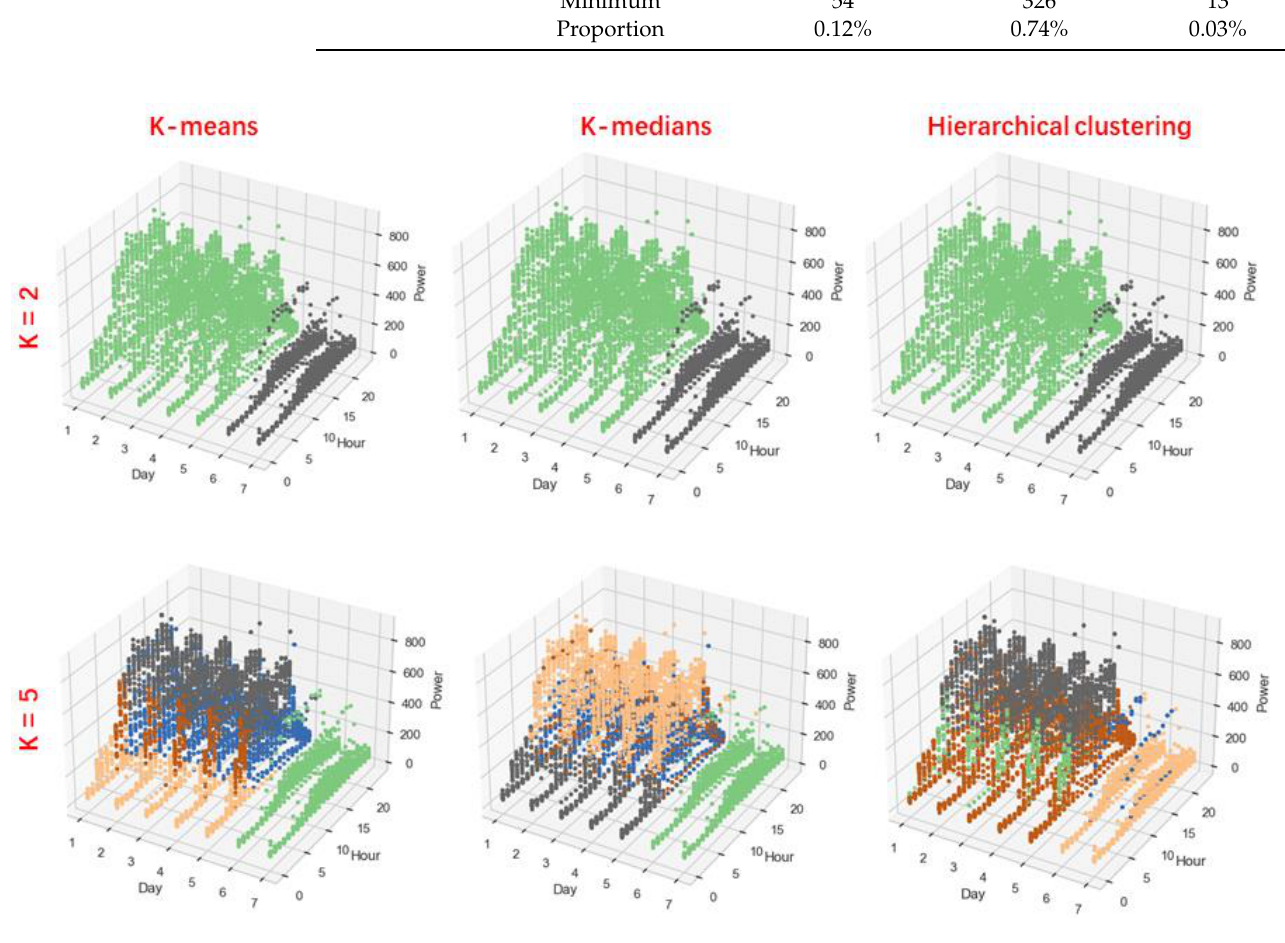
Figure 9. Cluster results when K = 2 and K =